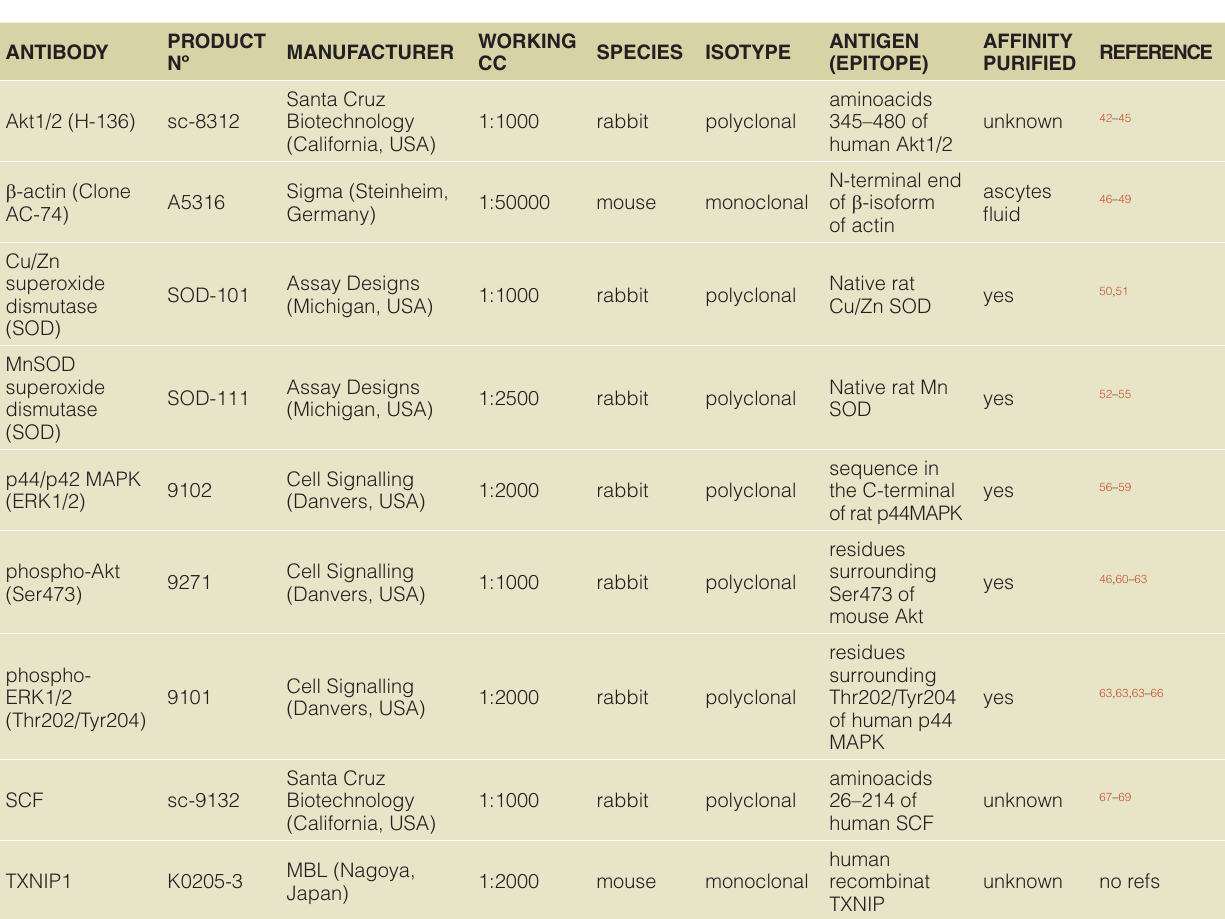
Table 1. Antibodies used in the study.